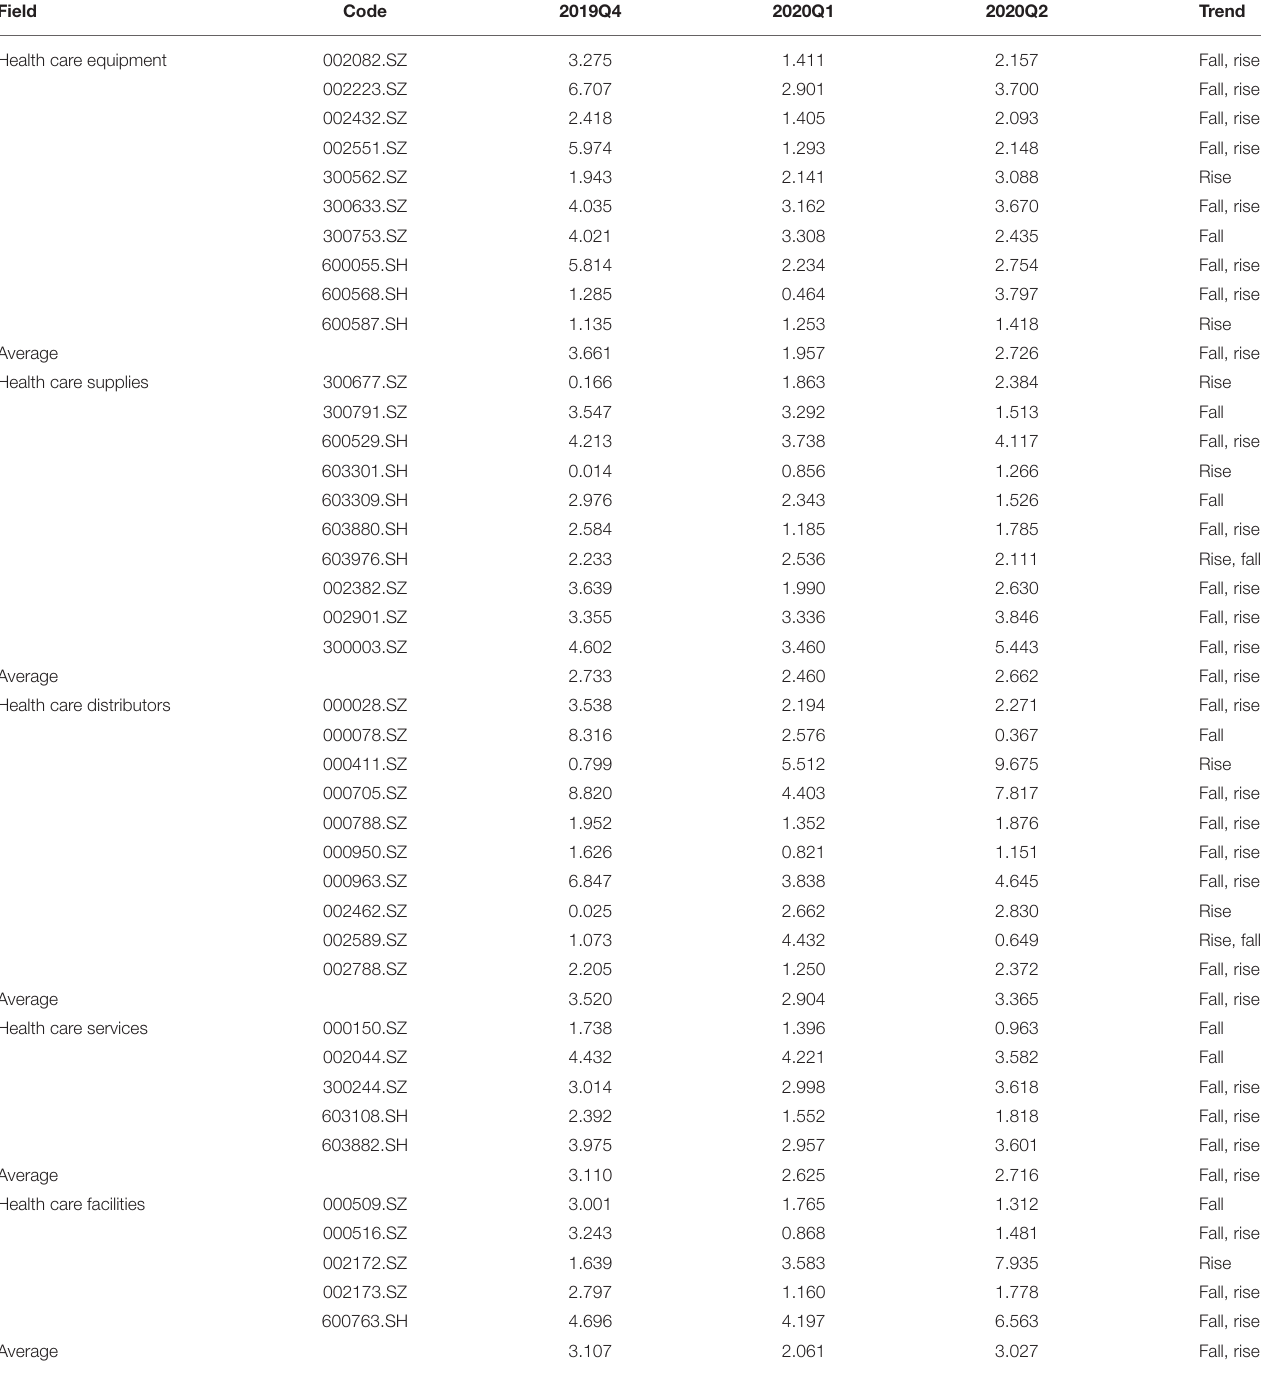
TABLE 4 | Default distance of health care